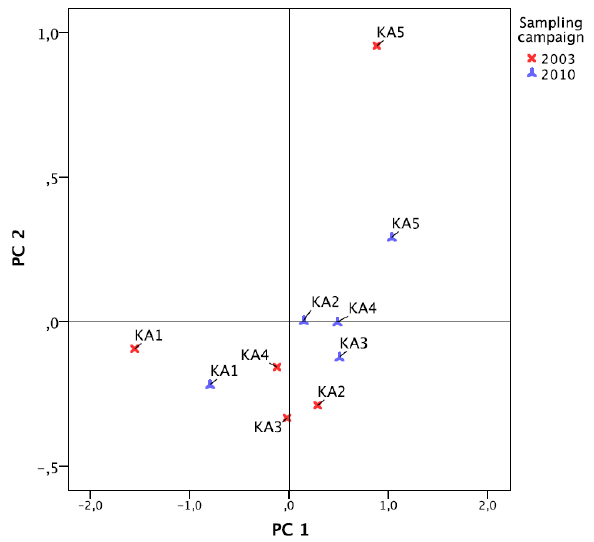
Figure 6. Scatter plot of scores during two sampling campaigns (2003 and 2010), corresponding to the first two principal components, for stations KA1 to KA5 of the Kadisha-Abou Ali River.